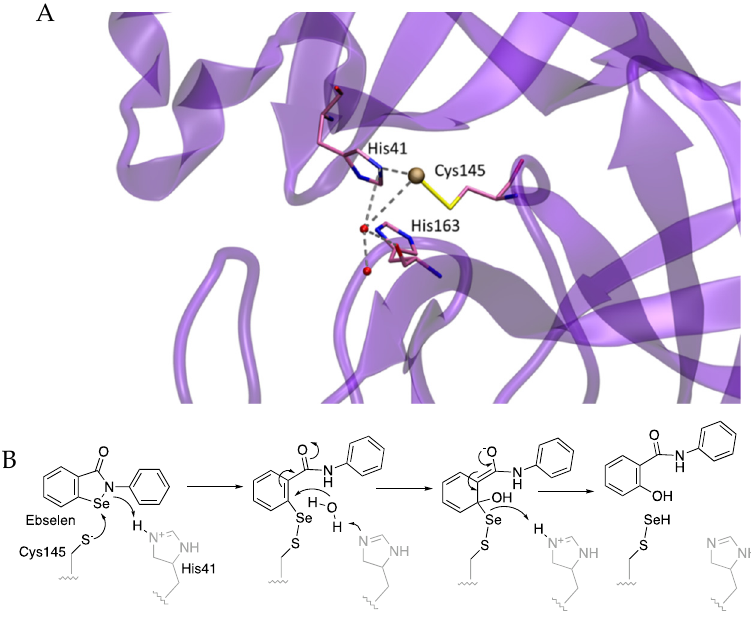
Figure 9. ( A ) Detail of crystal structure of selenium–Mpro complex. ( B ) Mechanism of ebselen. K ‐ W. Yang et al. performed a FRET screening study of 36 compounds structurally